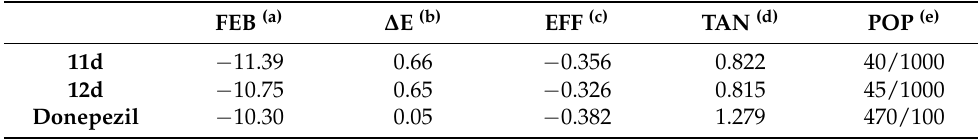
Table 5. Docking scores for compound 11d and 12d to